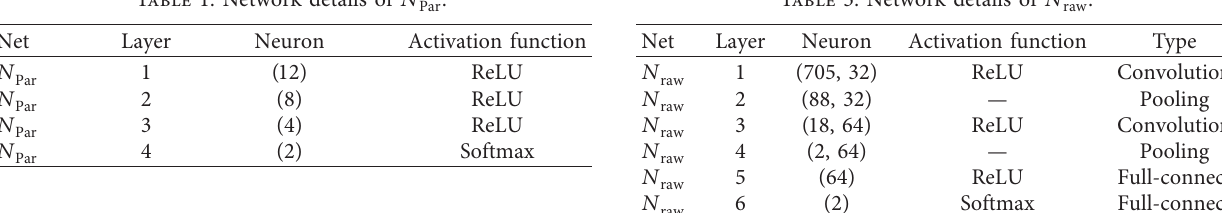
Table 3: Network details of N raw